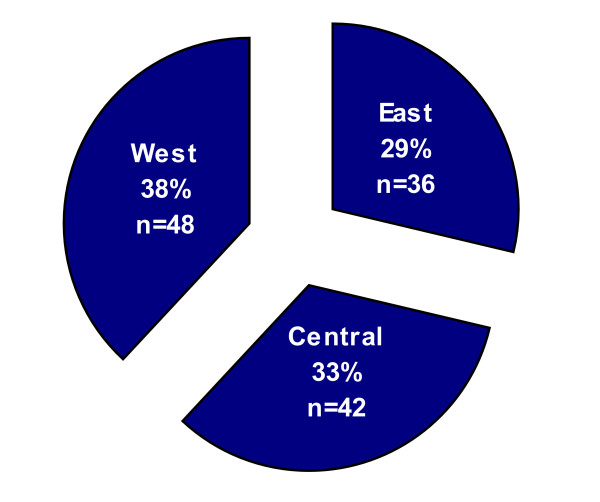
The figure demonstrates an even distribution of participants from Canada's three geographical areas. West: Saskatchewan, Alberta, British Columbia, and the Yukon/North West Territories. Central: Ontario and Manitoba. East: Newfoundland, New Brunswick, Nova Scotia, and Quebec.